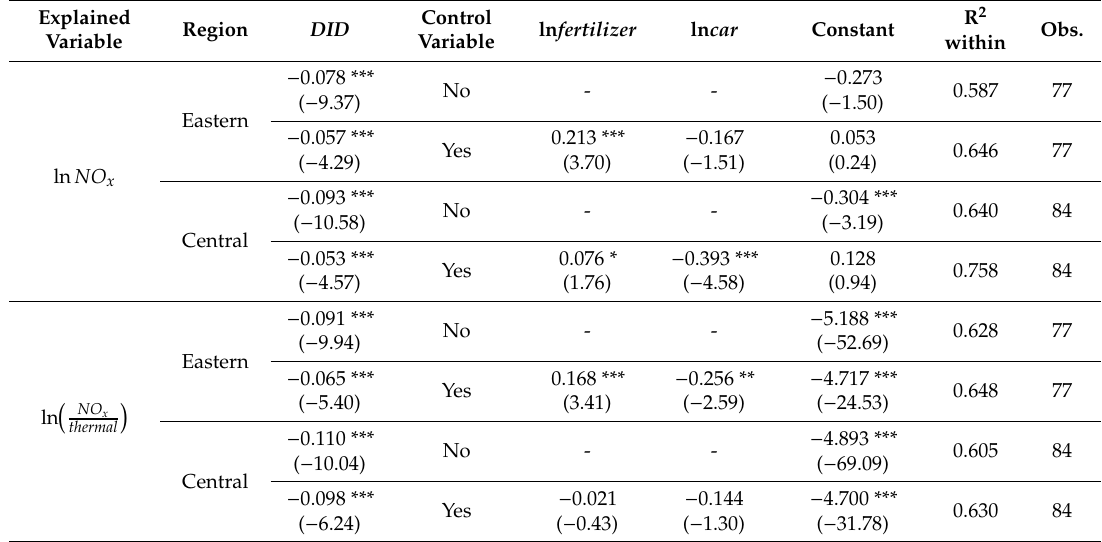
Table 5. Regression outcome for the ULE reduction e ff ect on NO